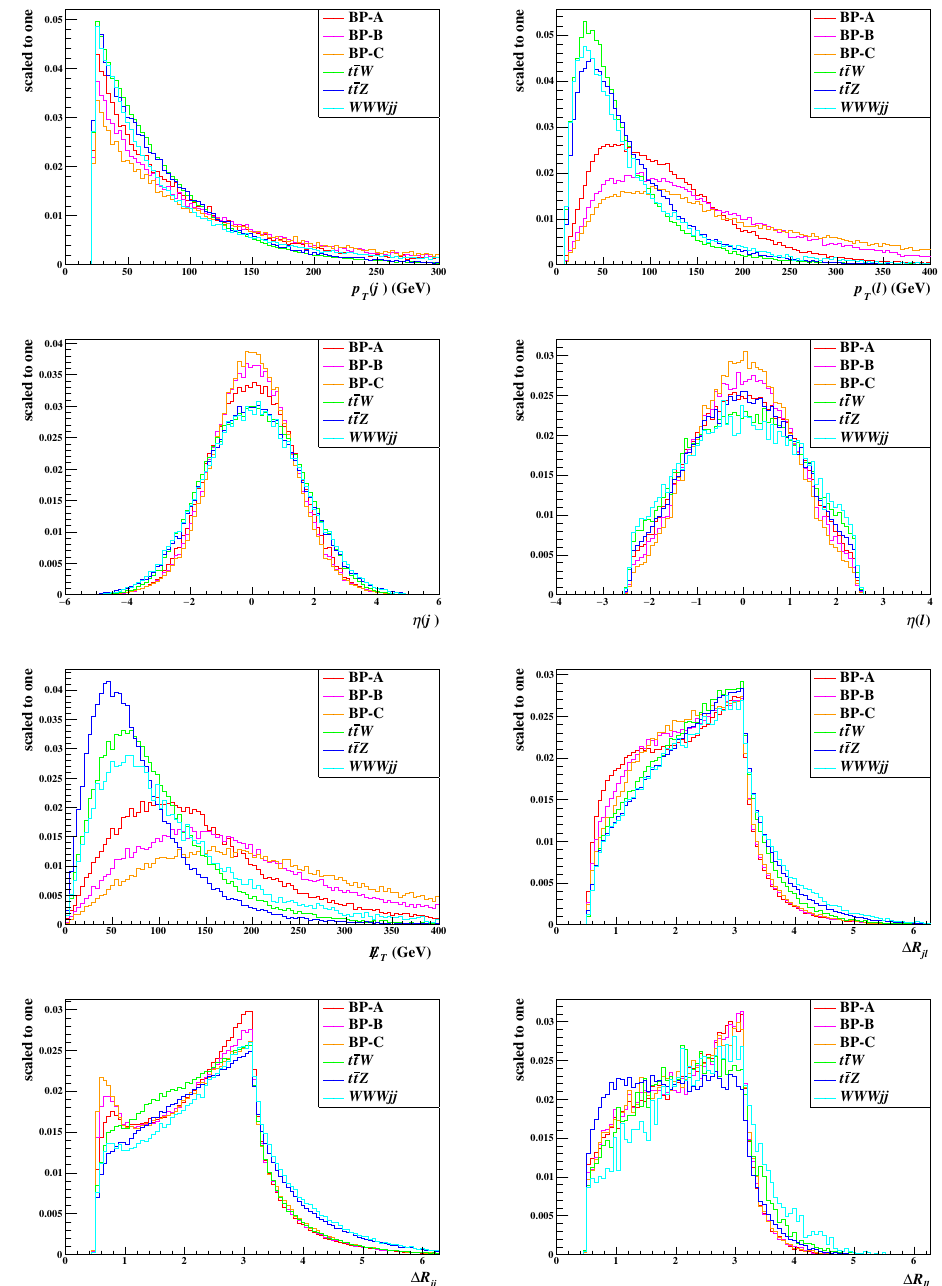
Figure 10 . Distributions of transverse momenta p T ( j ) ; p T ( ‘ ), pseudorapidities (cid:17) ( j ) ; (cid:17) ( ‘ ), missing transverse energy =E , and relative distances (cid:1) R j‘;jj;‘‘ for the SSD signature and corresponding T backgrounds at 13 TeV LHC.